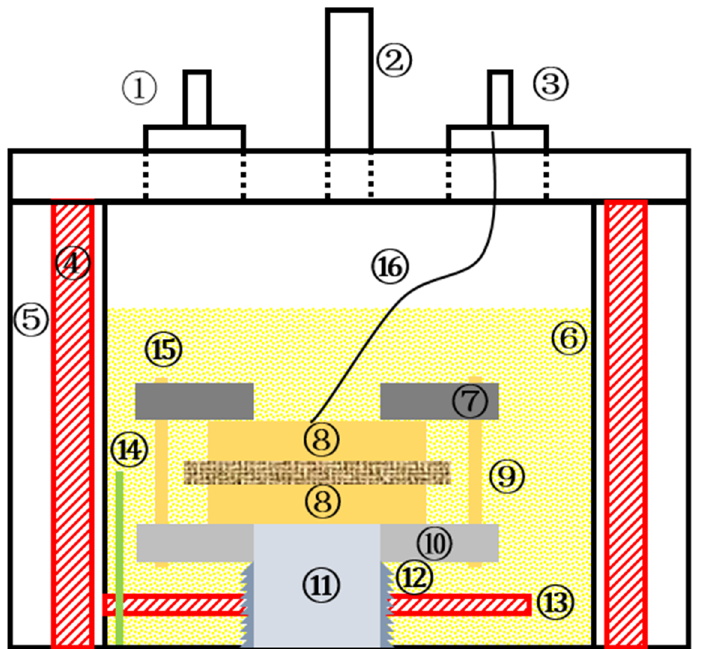
Figure 2. Aging chamber diagram ( 1 (cid:13) pressure relief valve, 2 (cid:13) gas injection valve, 3 (cid:13) bushing, Figure 2. Aging chamber diagram ( ① pressure relief valve, ② gas injection valve, ③ bushing, ④ Figure 2. Aging chamber diagram ( ① pressure relief valve, ② gas injection valve, ③ bushing, ④ Figure 2. Aging chamber diagram ( ① pressure relief valve, ② gas injection valve, ③ bushing, ④ Figure 2. Aging chamber diagram ( ① pressure relief valve, ② gas injection valve, ③ bushing, ④ Figure 2. Aging chamber diagram ( ① pressure relief valve, ② gas injection valve, ③ bushing, ④ Figure 2. Aging chamber diagram ( ① pressure relief valve, ② gas injection valve, ③ bushing, ④ Figure 2. Aging chamber diagram ( ① pressure relief valve, ② gas injection valve, ③ bushing, ④ insulating layer, ⑤ stainless steel cavity, ⑥ transformer oil, ⑦ mica board, ⑧ copper electrode 4 (cid:13) insulating layer, 5 (cid:13) stainless steel cavity, 6 (cid:13) transformer oil, 7 (cid:13) mica board, 8 (cid:13) copper electrode insulating layer, ⑤ stainless steel cavity, ⑥ transformer oil, ⑦ mica board, ⑧ copper electrode insulating layer, ⑤ stainless steel cavity, ⑥ transformer oil, ⑦ mica board, ⑧ copper electrode insulating layer, ⑤ stainless steel cavity, ⑥ transformer oil, ⑦ mica board, ⑧ copper electrode insulating layer, ⑤ stainless steel cavity, ⑥ transformer oil, ⑦ mica board, ⑧ copper electrode insulating layer, ⑤ stainless steel cavity, ⑥ transformer oil, ⑦ mica board, ⑧ copper electrode insulating layer, ⑤ stainless steel cavity, ⑥ transformer oil, ⑦ mica board, ⑧ copper electrode plate, ⑨ insulating pressboard, ⑩ aluminum board, ⑪ aluminum rod, ⑫ bellows, ⑬ heating plate, ⑨ insulating pressboard, ⑩ aluminum board, ⑪ aluminum rod, ⑫ bellows, ⑬ heating plate, ⑨ insulating pressboard, ⑩ aluminum board, ⑪ aluminum rod, ⑫ bellows, ⑬ heating plate, 9 (cid:13) insulating pressboard, plate, ⑨ insulating pressboard, ⑩ aluminum board, ⑪ aluminum rod, ⑫ bellows, ⑬ heating plate, ⑨ insulating pressboard, ⑩ aluminum board, ⑪ aluminum rod, ⑫ bellows, ⑬ heating plate, ⑨ insulating pressboard, ⑩ aluminum board, ⑪ aluminum rod, ⑫ bellows, ⑬ heating pipe, ⑭ thermocouple, ⑮ bolt, ⑯ high-temperature wire). pipe, ⑭ thermocouple, ⑮ bolt, ⑯ high-temperature wire). pipe, ⑭ thermocouple, ⑮ bolt, ⑯ high-temperature wire). pipe, ⑭ thermocouple, ⑮ bolt, ⑯ high-temperature wire). pipe, ⑭ thermocouple, ⑮ bolt, ⑯ high-temperature wire). pipe, ⑭ thermocouple, ⑮ bolt, ⑯ high-temperature